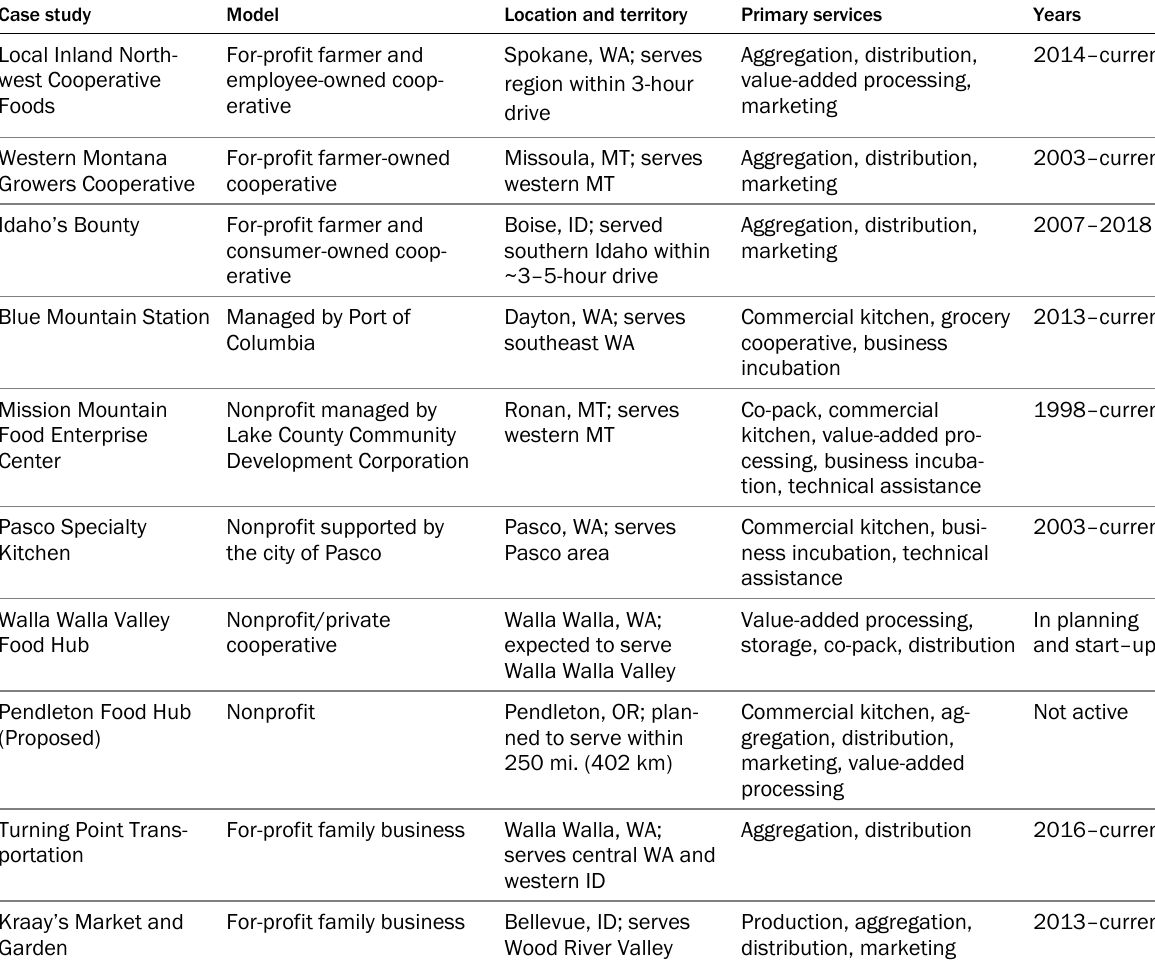
Table 1. Case Study Food Hub Overview Case